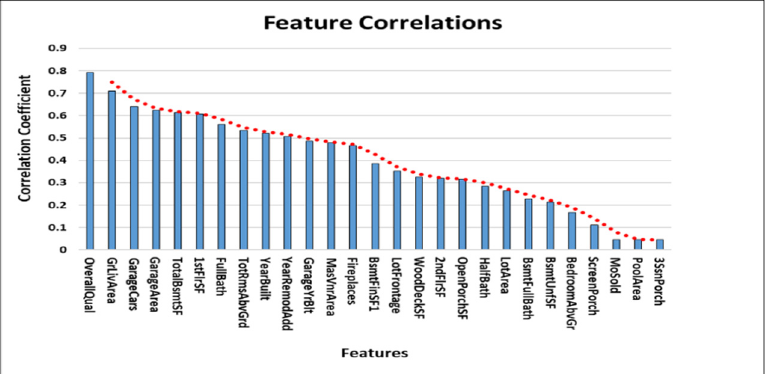
Figure 2. Correlation coefficients based on sale price of each house.